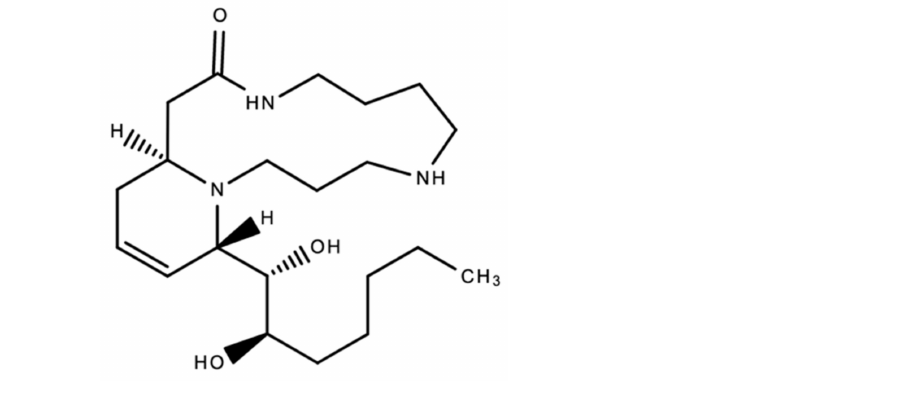
Figure 8. The chemical structure of cannabisativine, the first cannabinaceous alkaloid to be fully identified.